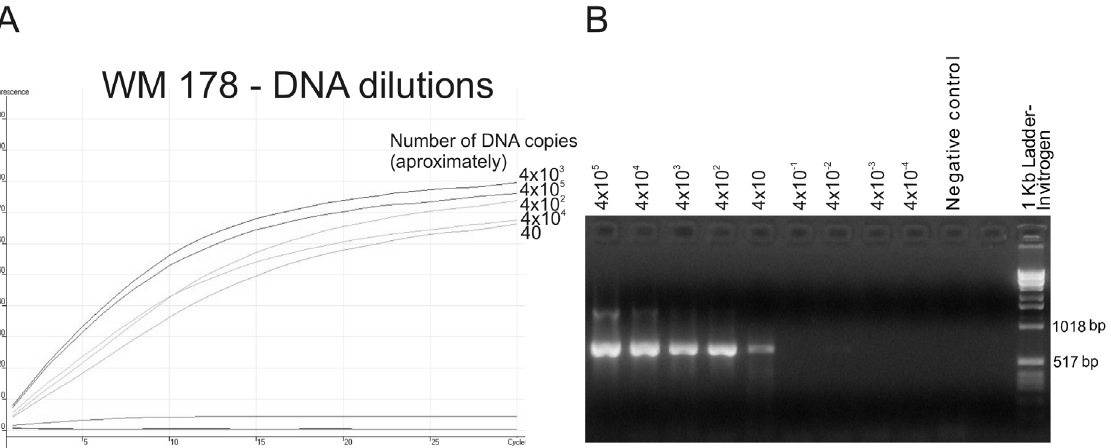
Figure 2. Detection limit of the HRCA after semi-nested PCR. ( A ) Real-time-PCR amplification curves for the semi-nested PCR amplification of the PLB1 locus from serial DNA dilutions of the strain WM 178 with the HRCA VGII probe. Lower curves correspond to dilutions with less than 40 copies of DNA (4 6 10 2 1 , 4 6 10 2 2 , 4 6 10 2 3 , 4 6 10 2 4 ); ( B ) PLB1 locus semi-nested PCR products from serial DNA dilutions of WM 179 strain separated on a 1.4% agarose gel.